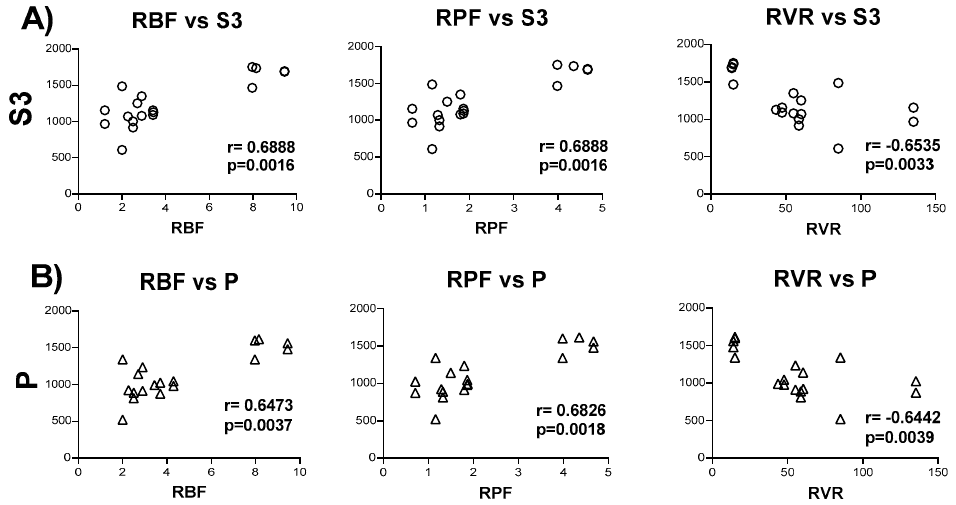
Figure 4. Pearson correlations among changes in energy parameters and hemodynamics parameters. Pearson correlation among the alteration in the nephrectomized group in the respiratory parameters in complex I-linked respiration ( A ) state 3 (S3) and ( B ) oxidative phosphorylation (OXPHOS)-associated respiration (P), and the changes in hemodynamics parameters on days 7, 14, and 28 after surgery. RBF = renal blood flow; RPF = renal plasma flow; RVR = renal vascular resistance.